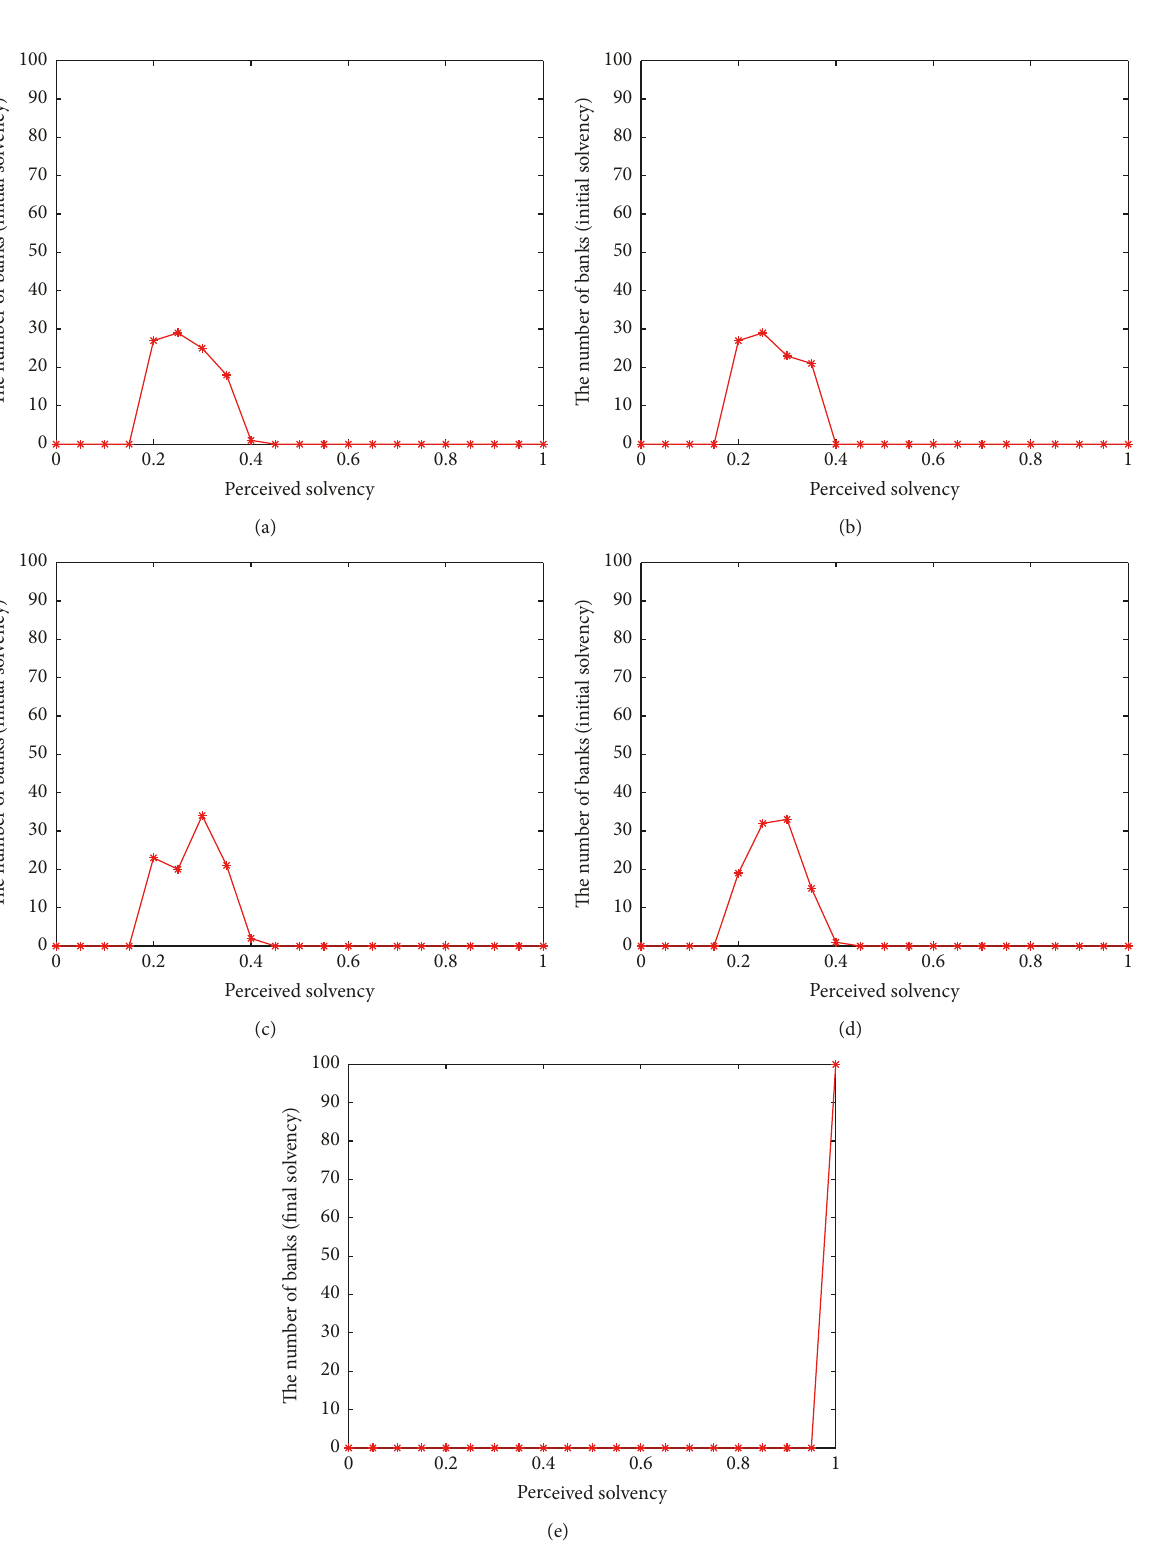
Figure 1: Different random distribution of